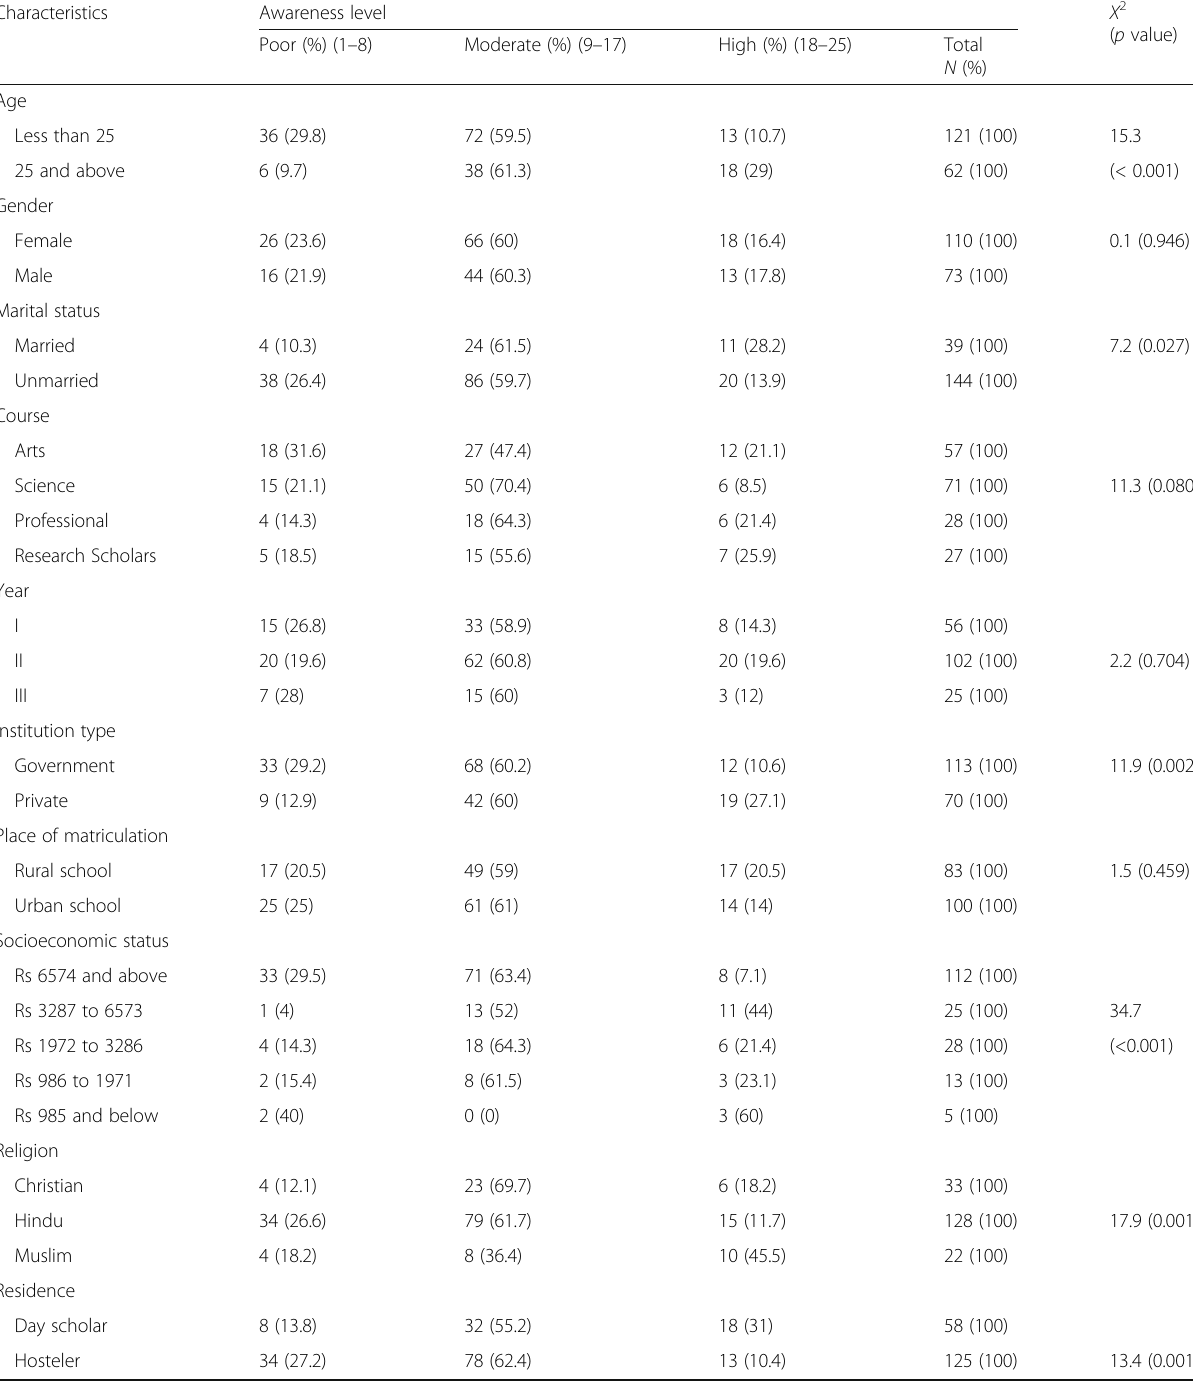
Table 3 Association between the socio-demographic variables and the awareness level of college students regarding the emergency contraception ( n = 183 )